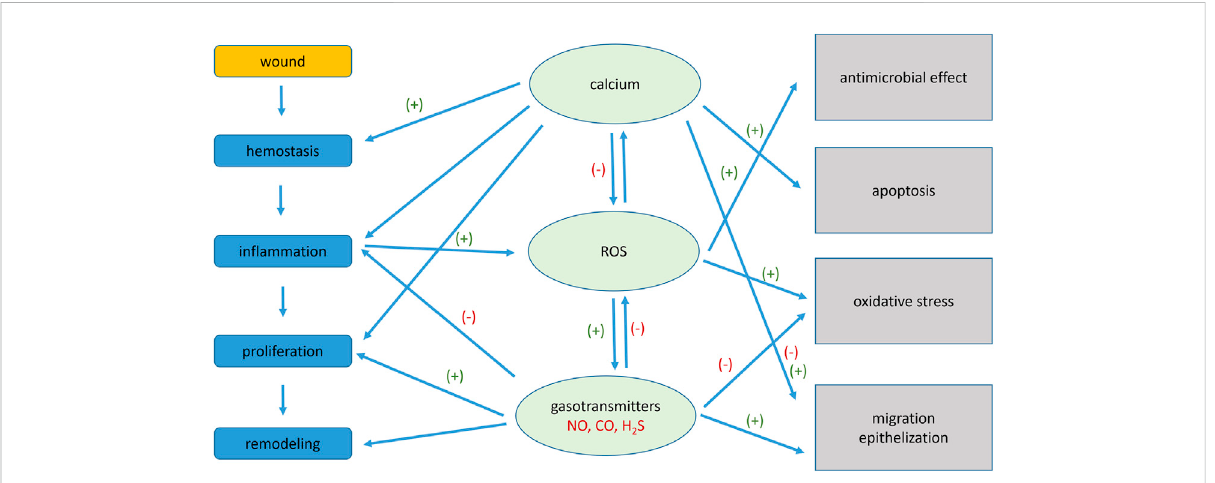
FIGURE 1 Schematic interaction of signalling molecules (calcium ions, ROS and gasotransmitters) in the individual phases of wound healing and their effects. Calcium ions affect hemostasis, in fl ammation and also proliferative phase of wound healing, which have an impact on the process of apoptosis, epithelization and migration. Gasotransmitters affect in fl ammation, proliferation and remodelling and signi fi cantly affect the amount of reactive oxygen species (ROS) and thus oxidative stress and also epithelization and migration. (+) represents positive effect, ( − ) represents negative